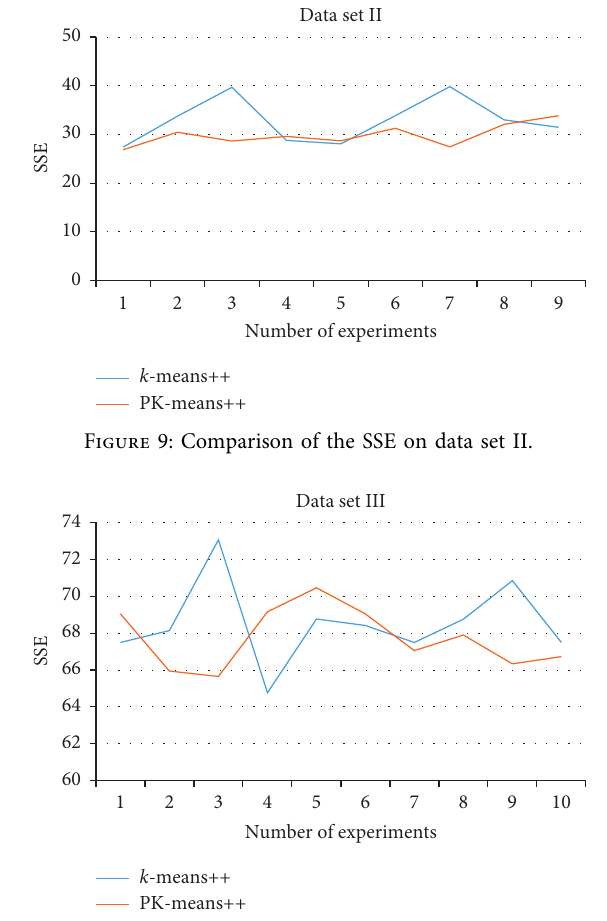
Figure 10: Comparison of the SSE on data set III.